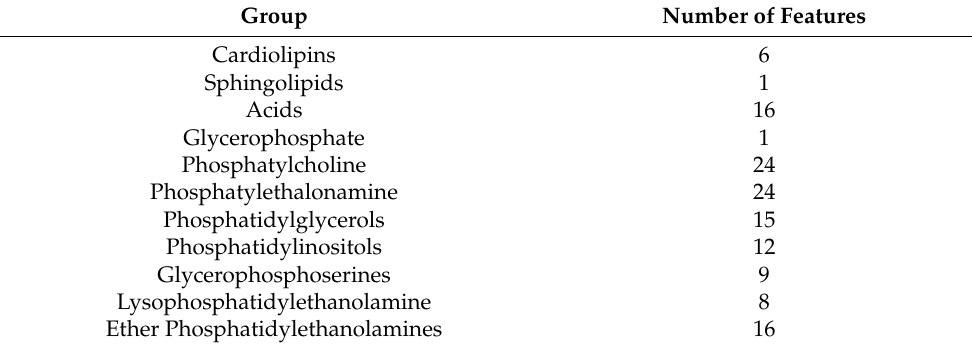
Table 1. Grouped features according to their super class; ION C18 negative mode